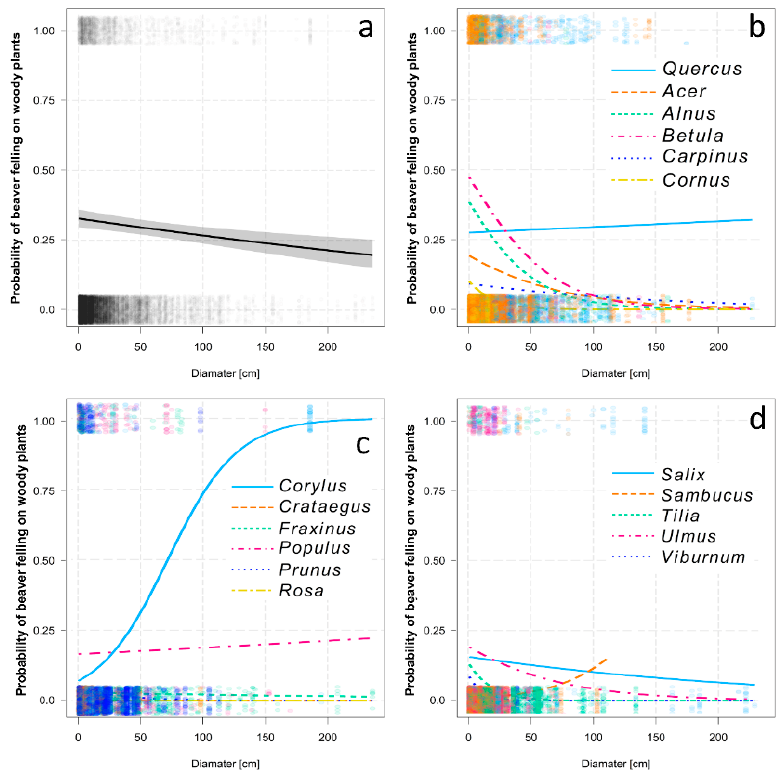
Figure 4. Probability of beaver felling on woody plants with increasing diameter: ( a ) overall model after controlling the other effects (spatial variance, distance from water), ( b – d ) models for individual woody plant genera showing interactions.